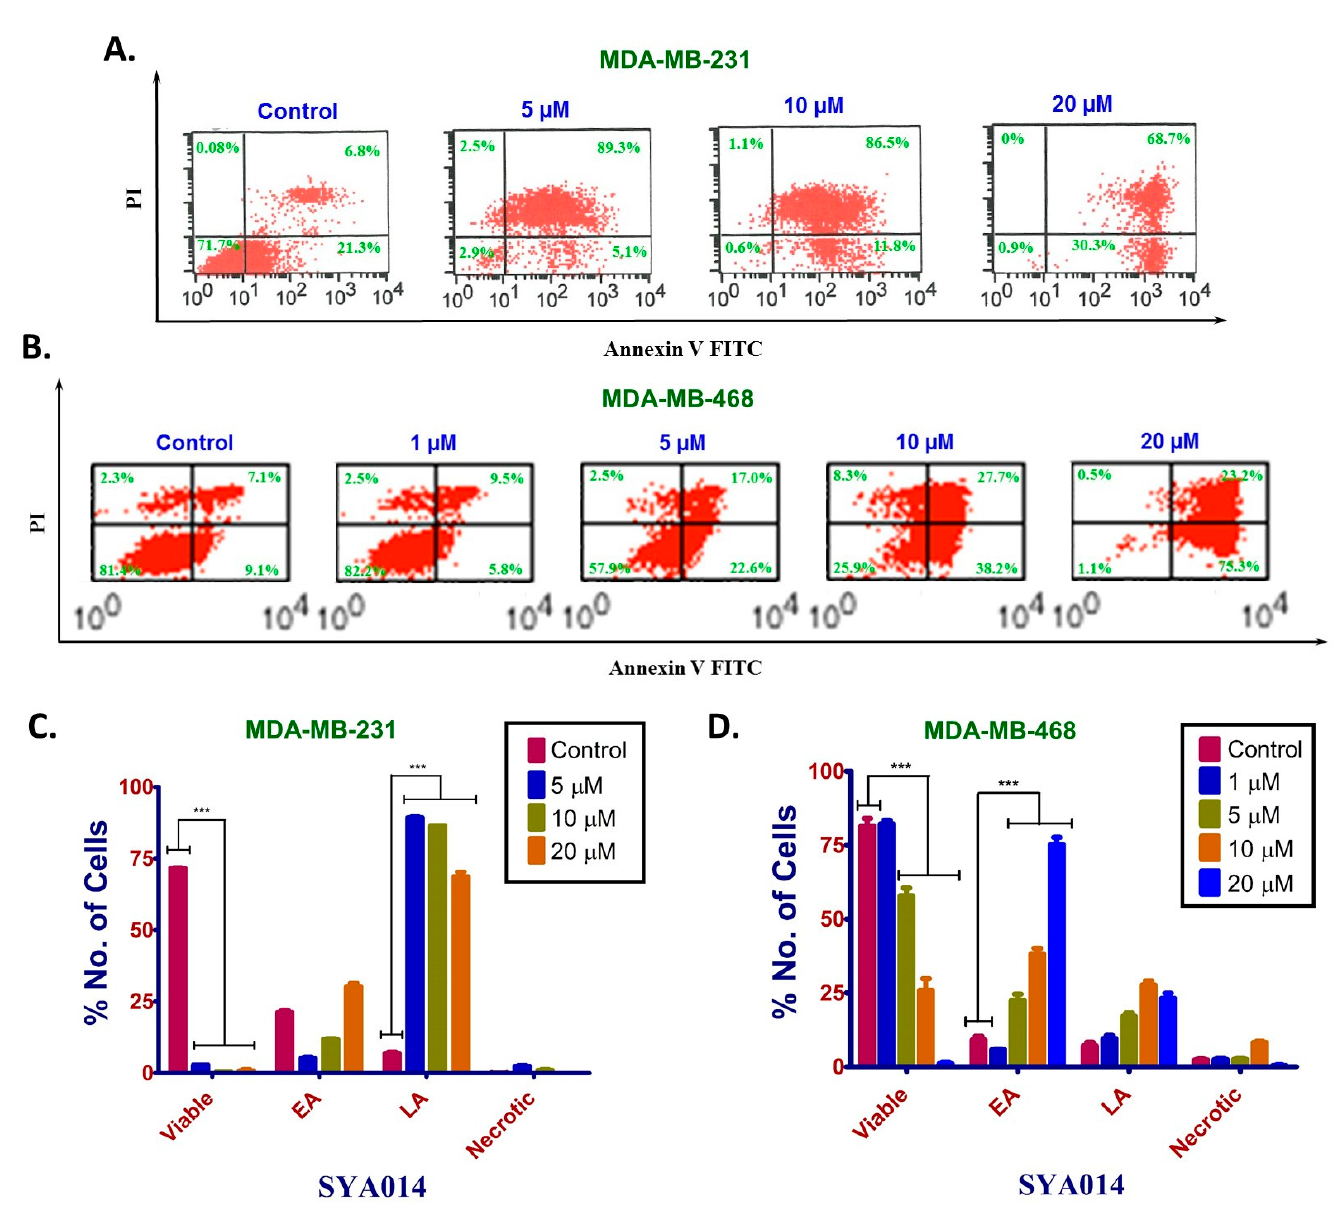
Figure 6. SYA014 triggers cell death by inducing apoptosis in TNBC cell lines. Annexin V and PI staining and flow cytometry analysis was conducted on MDA-MB-231 cells ( A ) and MDA-MB-468 cells ( B ) after treatment with SYA014 (0 − 20 µM) for 48 h. Data from the flow cytometry analysis for MDA-MB-231 cells and MDA-MB-468 cells were quantified as shown in ( C , D ), respectively *** p < 0.001. EA = early apoptosis; LA = late apoptosis. No. = number.